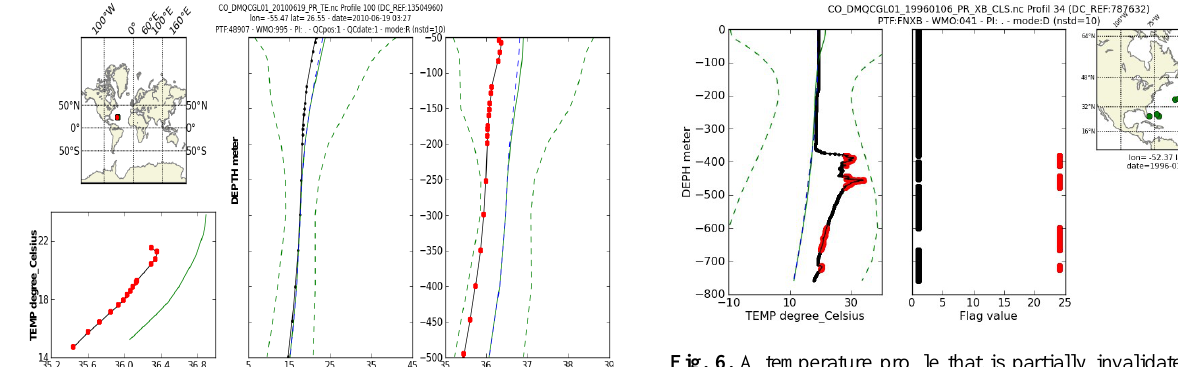
Fig. 6. A temperature profile that is partially invalidated because the temperature values are outside acceptable range (red dots). A visual check is needed to invalidate the other bad values. The quality flags of 24 are only for the purpose of the plot and indicate that this test (acceptable range) fails at some observed levels of the profile. This profile was visually checked before any flag was modified in the CORA3 dataset. After visualization, all the temperature values measured at depths below 360m were flagged as bad data (flag 4) in the CORA3